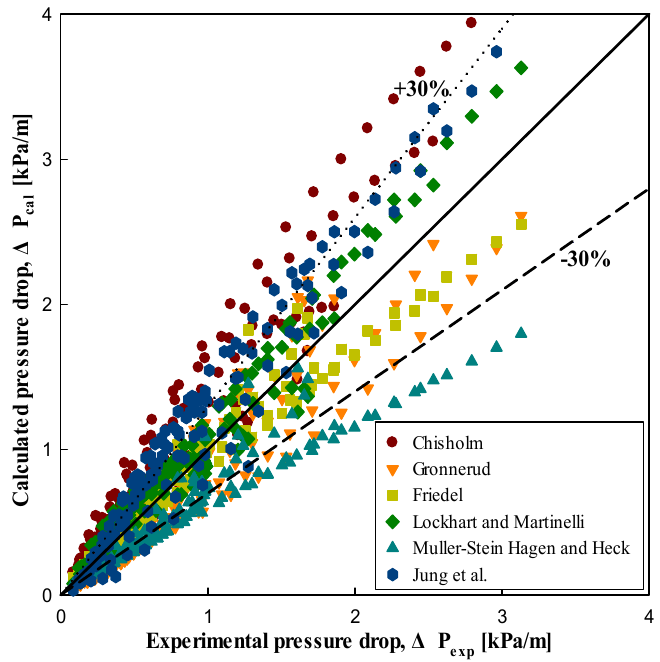
Figure 16. Comparison between measured and calculated frictional pressure drops for all data.